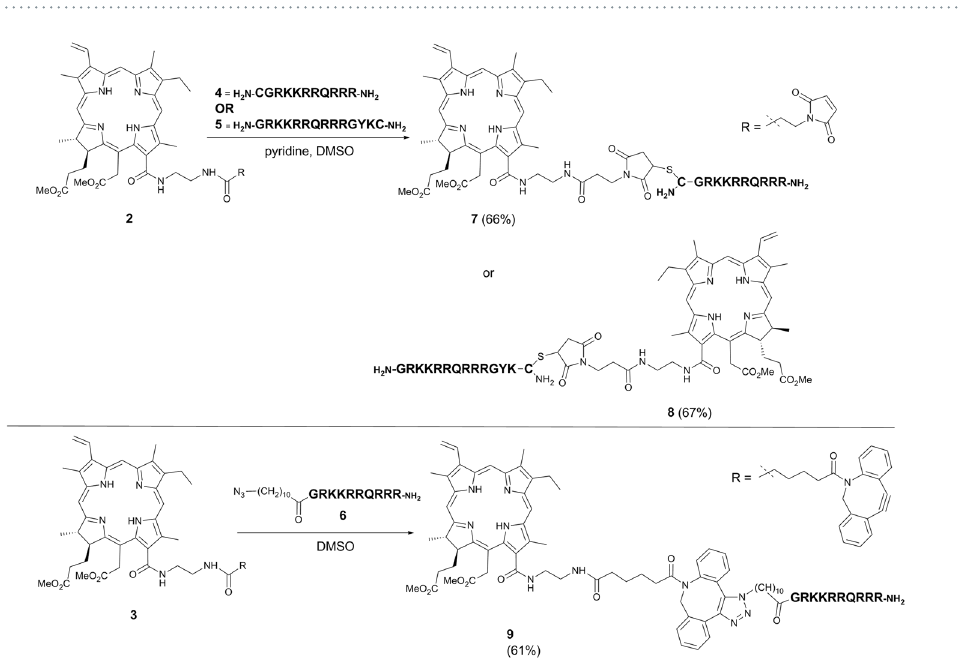
Figure 2. Synthesis of chlorin-Tat conjugates 7–9